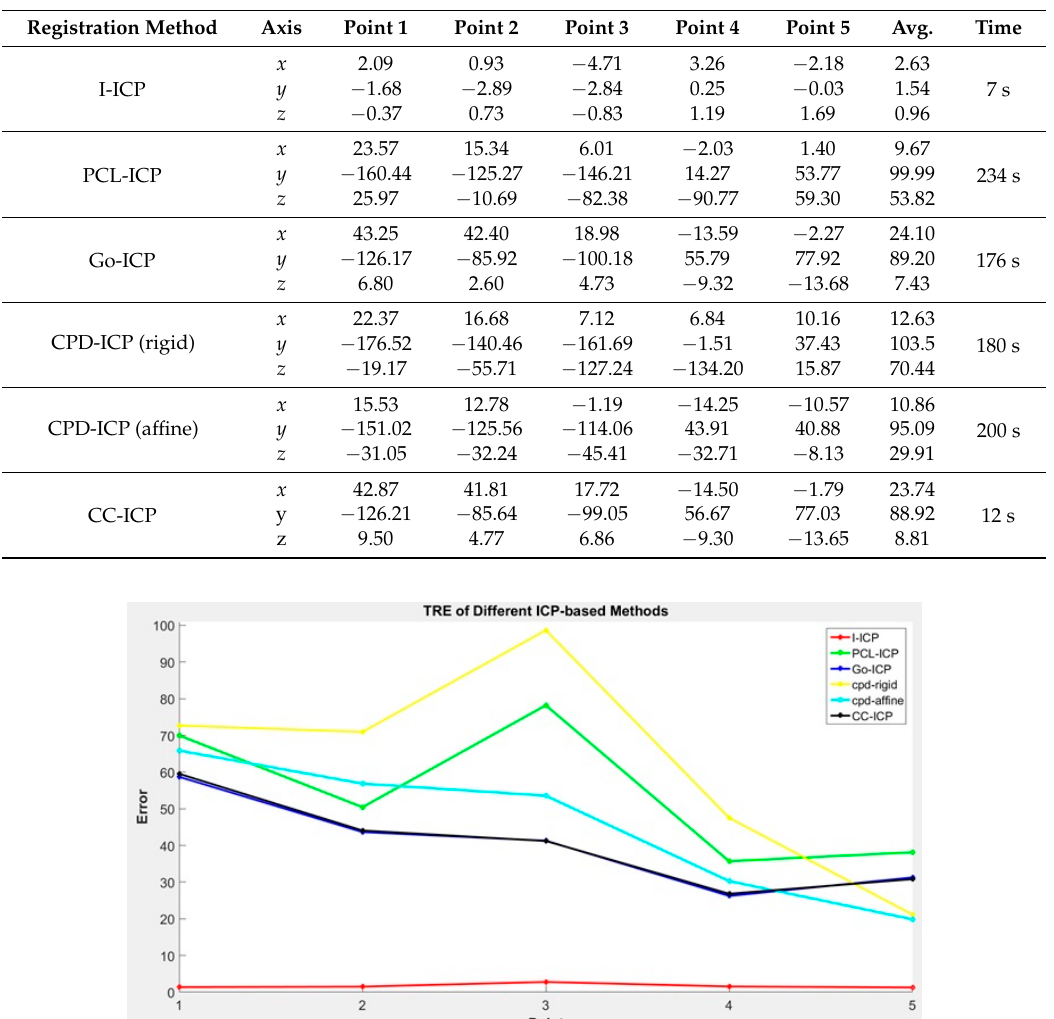
Table 3. Results of alignment errors comparison.